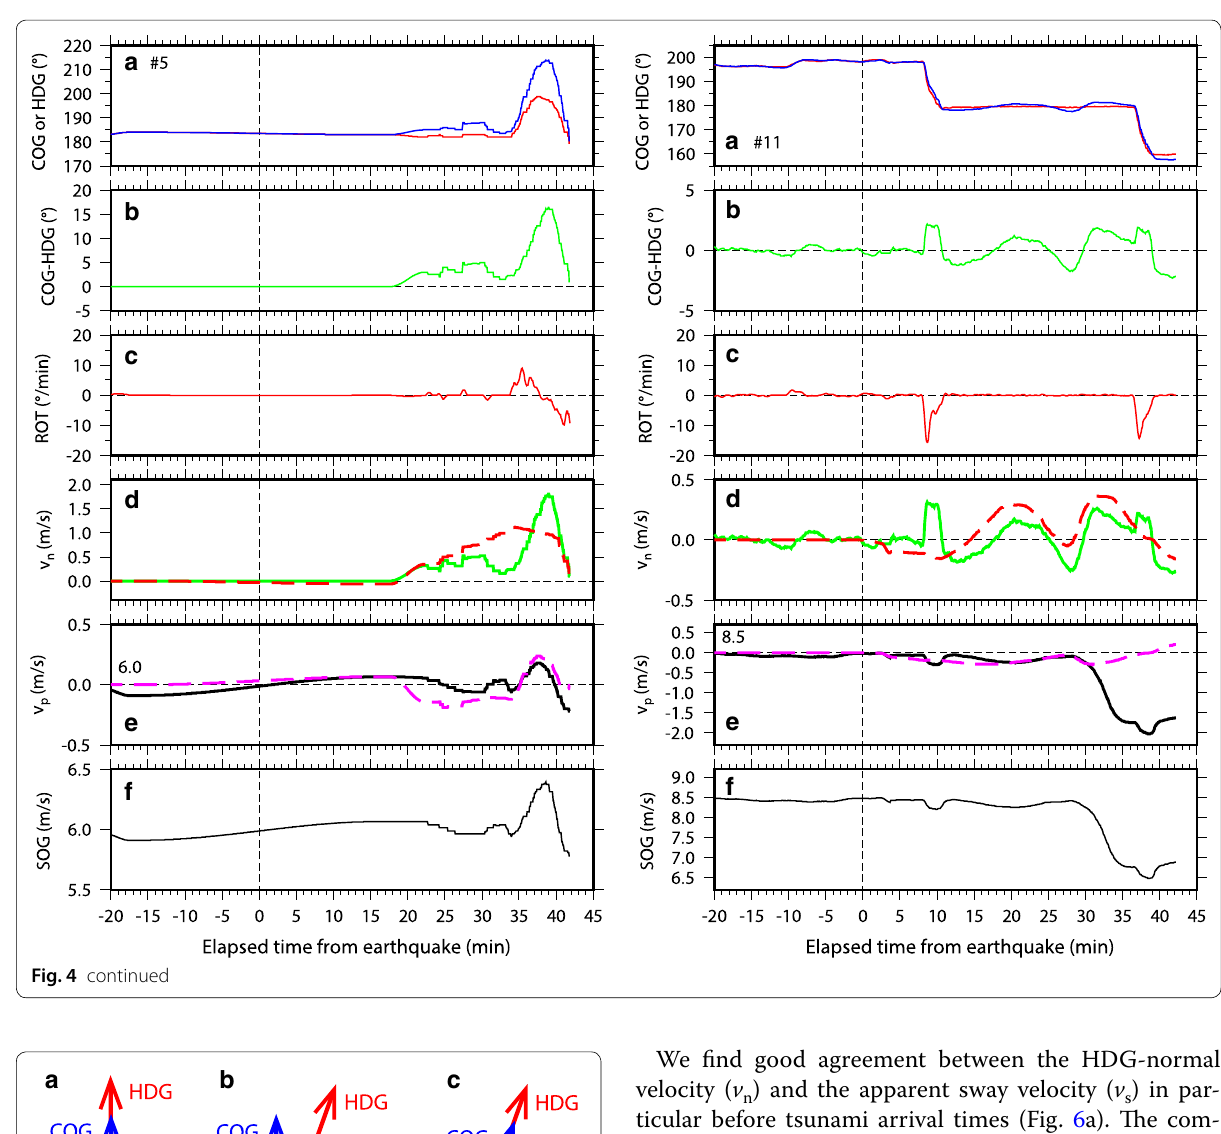
We find good agreement between the HDG-normal velocity ( v n ) and the apparent sway velocity ( v s ) in par- ticular before tsunami arrival times (Fig. 6a). The com- ponents derived from ROT are well corrected from the HDG-normal velocity, in particular for several ships of #3, #4, #6, and #11 (Fig. 6b). The corrected HDG-nor- mal velocity ( v v n v s ) shows better agreement with = − the simulated tsunami currents ( v c ). Correlation coeffi- cients between v n v s and v c (mean value of 0.78) become − greater than those between v n and v c , (0.72) for almost (11/13) of the ships (Figs. 3b and 6b). Such improve- ments in the correlation coefficients are also found for 10/13 ships when tsunami simulation employed the ini- tial condition of Saito et al. (2011) (Fig. 3a and Additional file 1: Fig. S2). The mean correlation coefficient similarly increases to 0.78 from 0.73. These indicate that the cor- rection using ROT robustly removes non-tsunami com- ponents in the AIS data. For the 2011 Tohoku tsunami, tsunami signals were evident without the correction